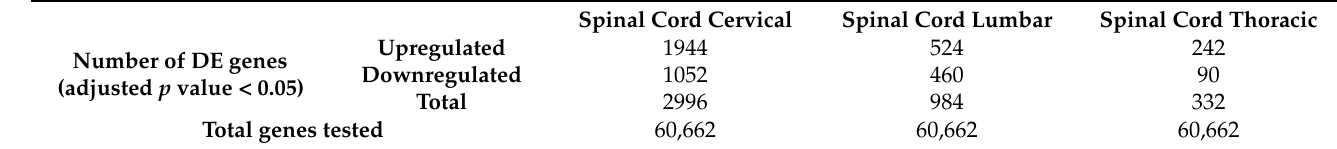
Table 2. Number of DE genes in each tissue type with adjusted p values < 0.05. Spinal Cord Cervical Spinal Cord Lumbar Spinal Cord